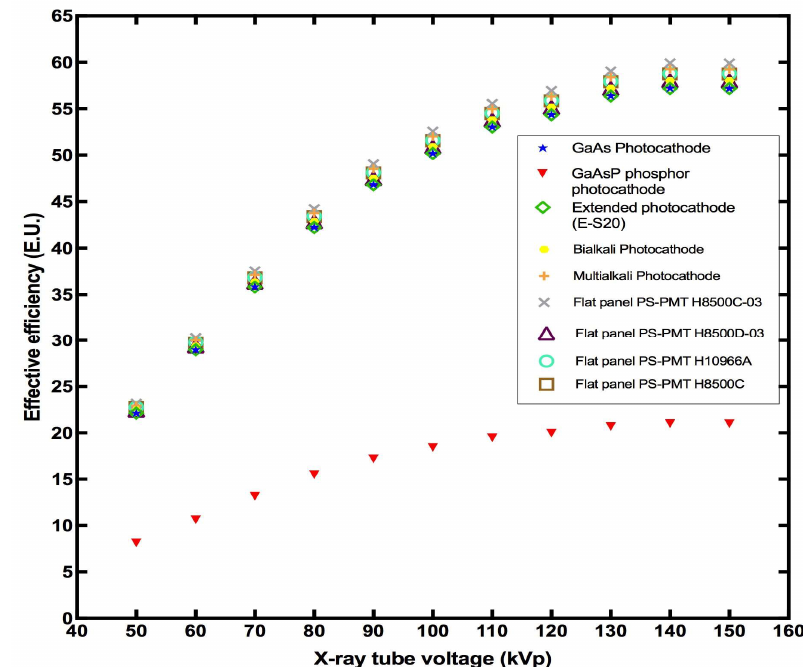
Figure 17. EE of the LaBr 3 :Ce combined with various photocathodes.